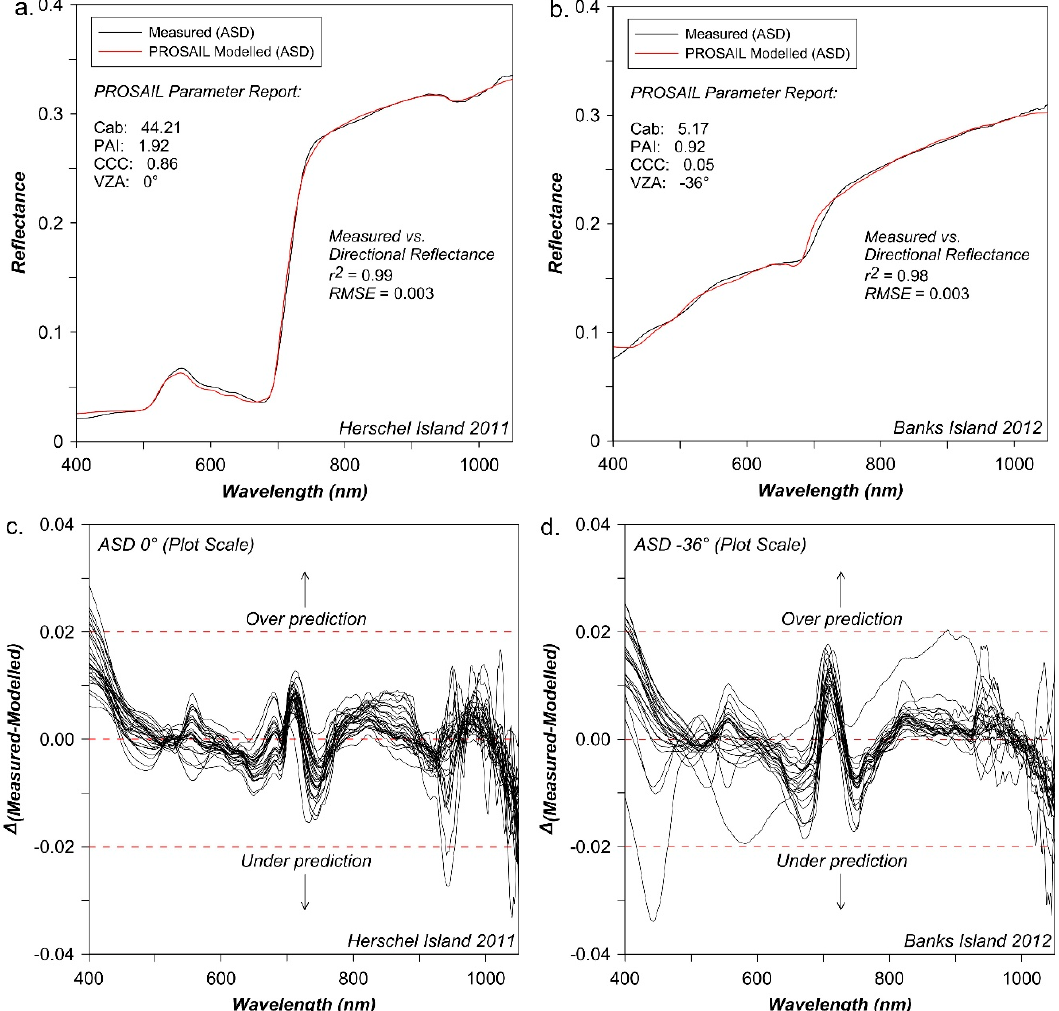
Figure 8. Examples representing the range of measured and modelled TOC spectral-directional reflectance curves using full spectrum ASD data. ( a ) A typical vegetation curve, Herschel Island (VZA = 0 ◦ ). ( b ) A reflectance curve typical of Banks Island (VZA = − 36 ◦ ) where vegetation is sparse. The error for LM inversions was typically < ~2%; the y-axis has been exaggerated to better highlight where these errors occur. The LM inversion error for ( c ) Herschel Island and ( d ) Banks Island are shown as examples.